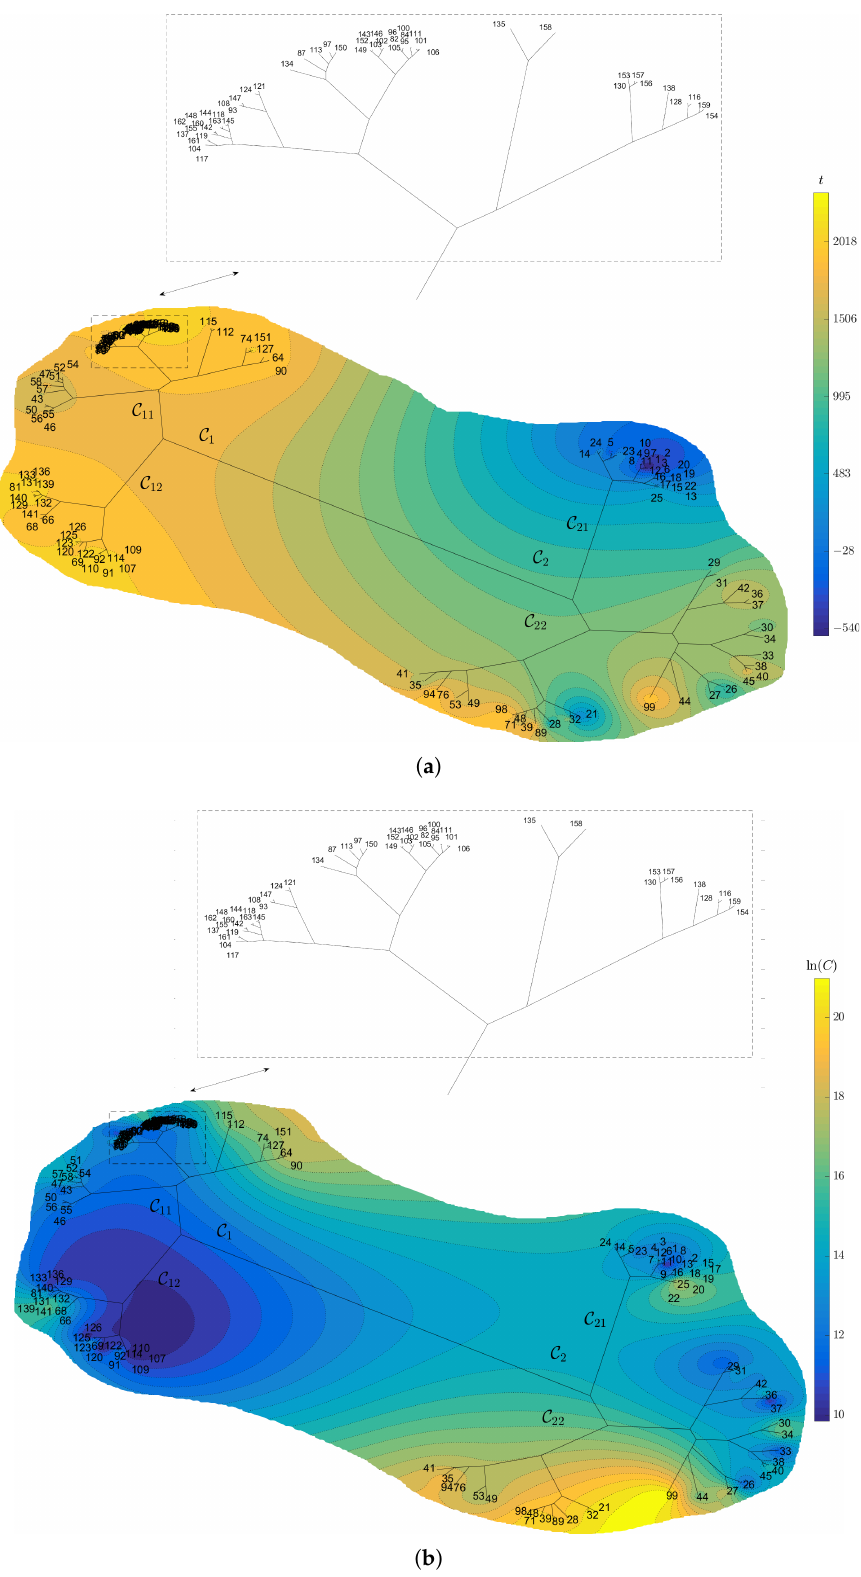
Figure 1. The hierarchical trees obtained with the Jaccard distance, d 6 , and the 3rd dimension calculated by RBI based on: ( a ) time (year), t ; ( b ) logarithm of the casualties, that is, ln ( C ) . A magnification of the denser part is